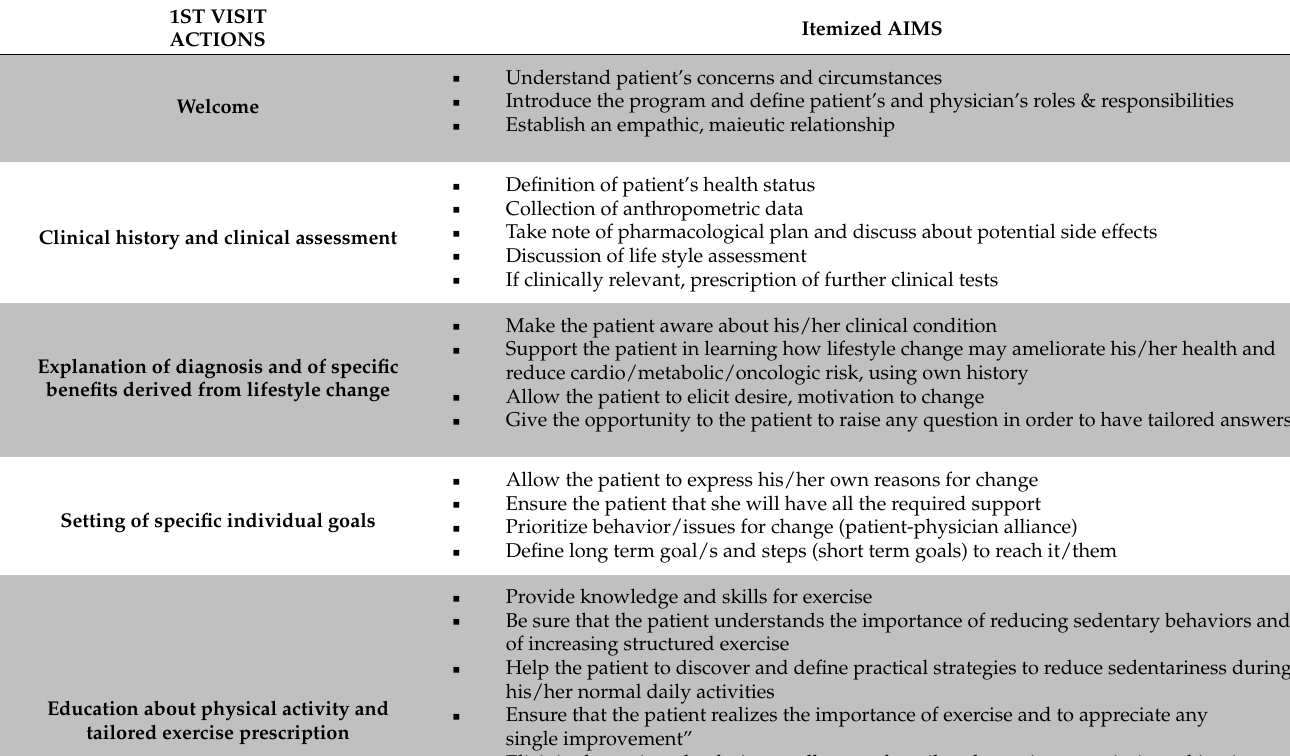
Table 4. Classification of physical activity intensity.